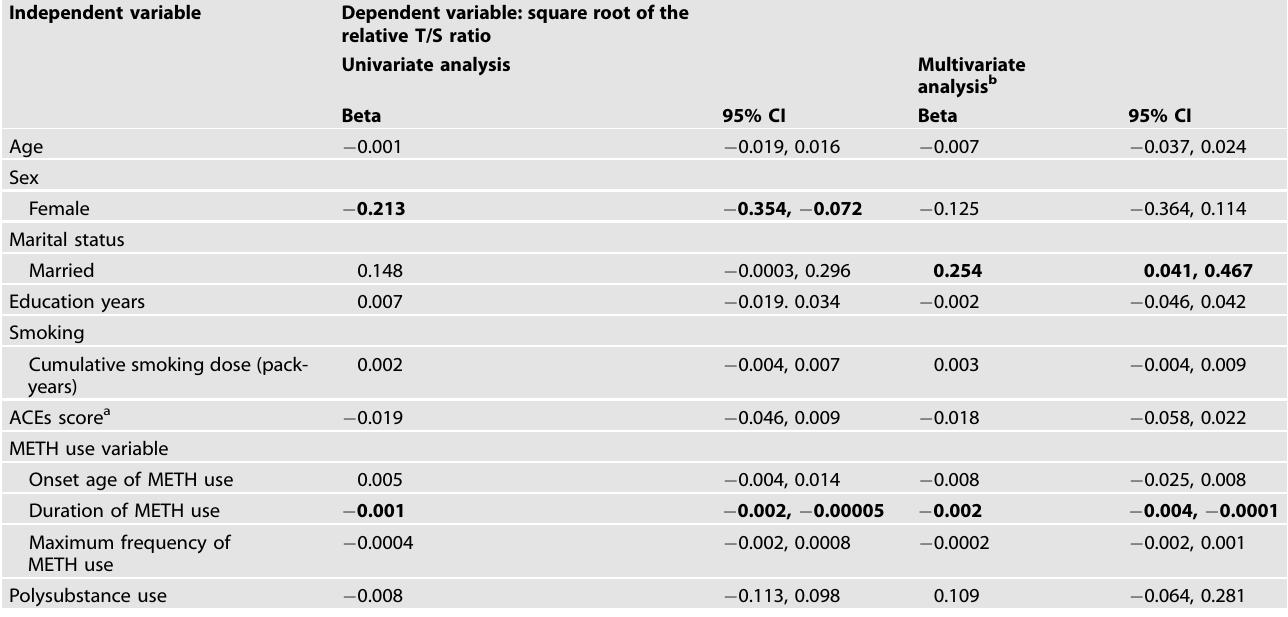
Table 3. Univariate and multivariate linear regression to examine the association of telomere length (dependent variable) with demographic, clinical, and METH use variables (independent variables) for METH users ( N =